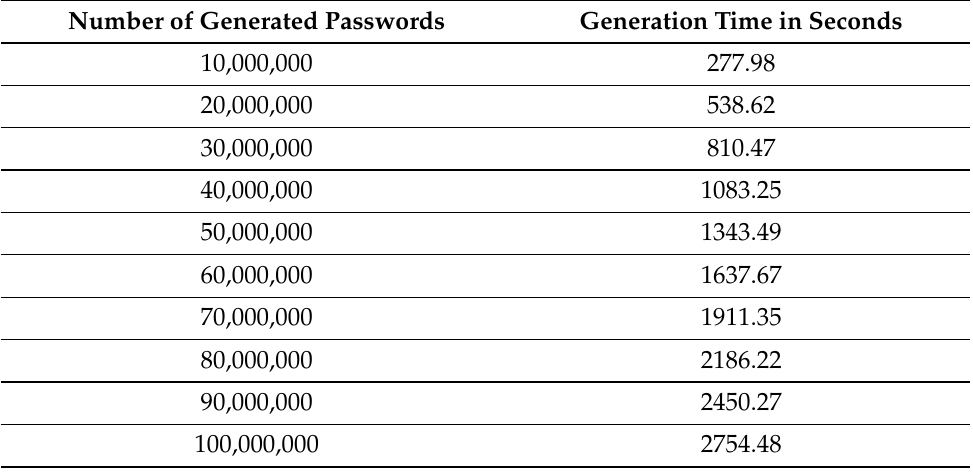
Table 2. Generation time for various sets of passwords.